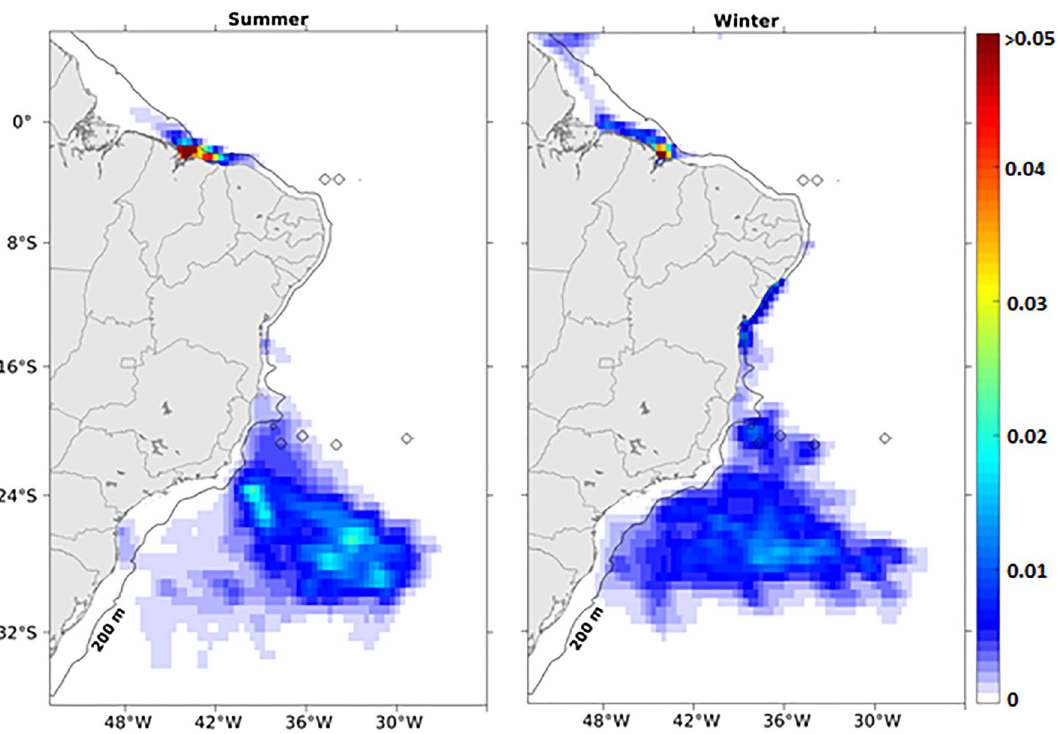
Figure 5. Kernel density estimation for the surviving larvae released from all the 26 source areas during the 90 days of austral summer (left) and winter (right) simulations. The empty circles on the maps are seamounts shallower than 200 m. Created with Matlab R2018a (http:// www. mathw orks.